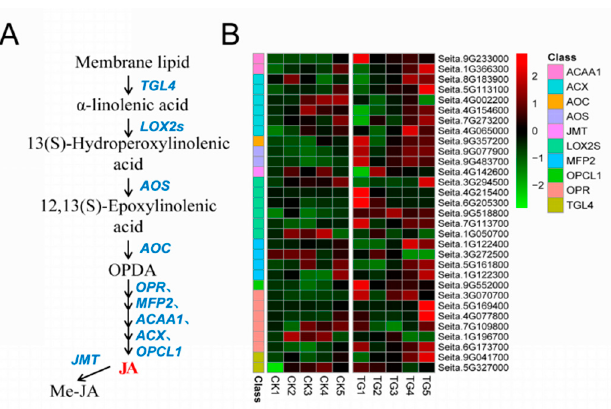
Figure 10. Jasmonic acid biosynthetic pathway and di ff erentially expressed genes. ( A ) Jasmonic acid biosynthetic pathway. ( B ) Heatmap of di ff erentially expressed genes related to this pathway. The FPKM values of the genes were normalized by Pheatmap package in R language before the heatmap was drawn. In the color legend on the right side of the heatmap, the color labels of each gene correspond to the bar graph on the left side of the heatmap. The experiment was repeated at least three times and the results were similar. The heatmap data are the average of the repeated FPKM values.